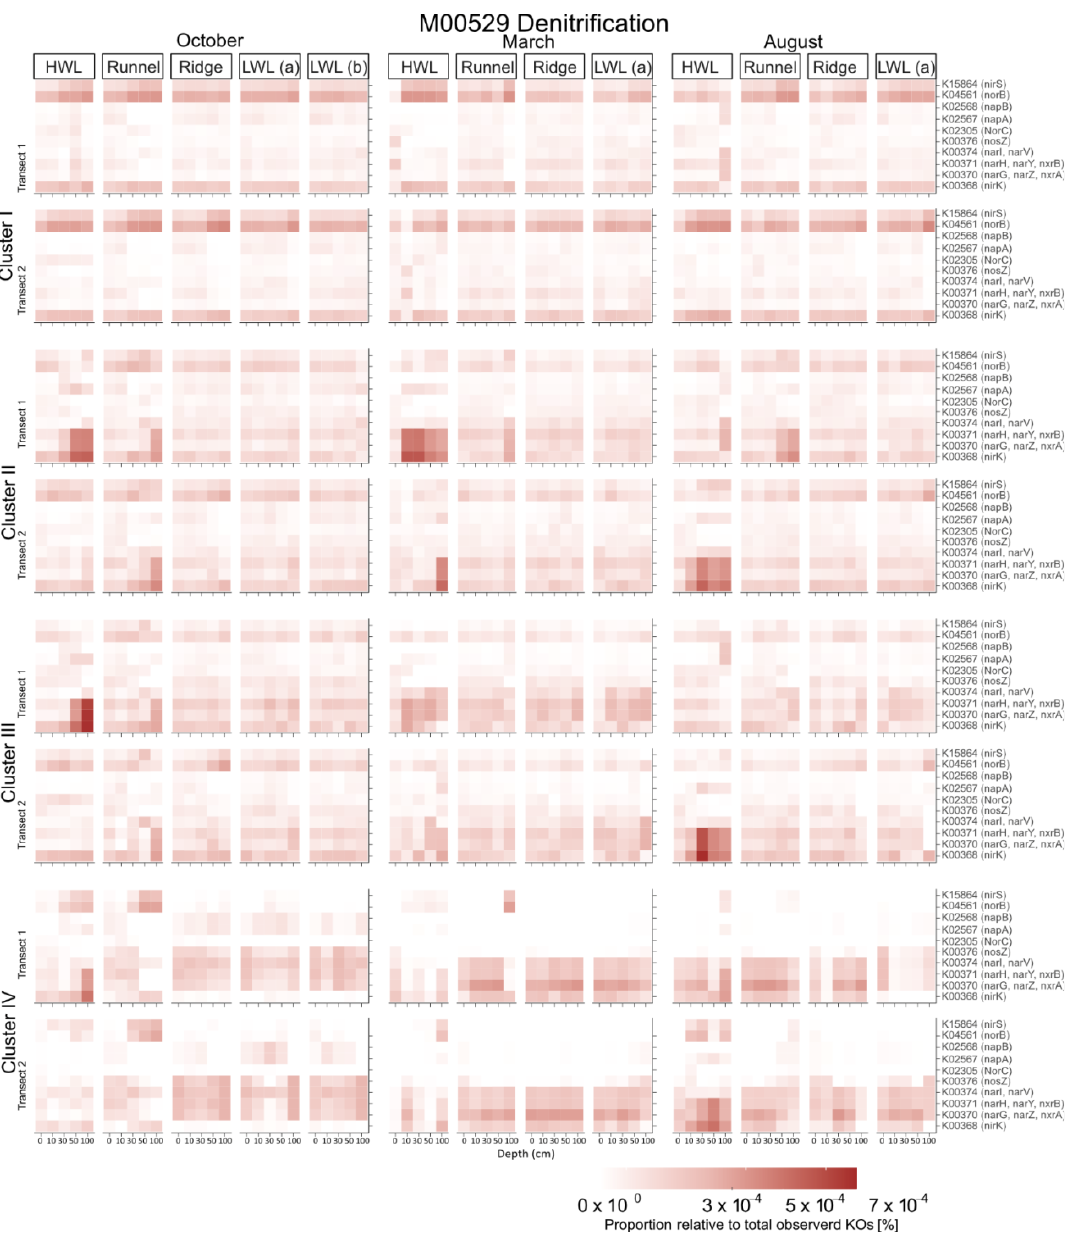
Figure 3. Predicted expression of genes involved in denitrification in relation to all KEGG orthologs (KOs) observed. Gene expression levels are presented individually for each of the four clusters at every station, depth, and month across the two transects sampled.